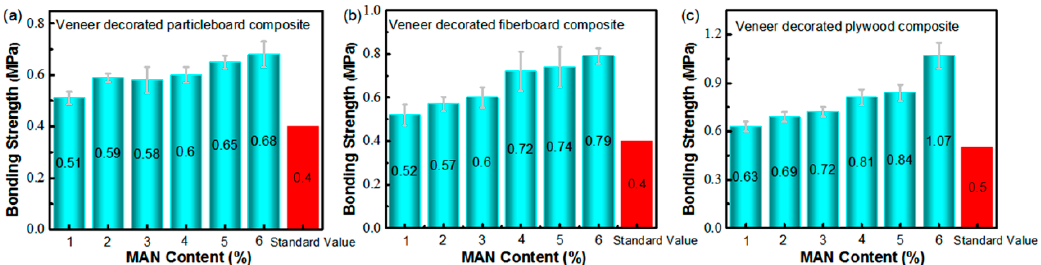
Figure 3. Optimization of the maleic anhydride (MAN) content of the three wood-based panel composites—( a ) the veneer-decorated particleboard composite; ( b ) the veneer-decorated fiberboard composite; and ( c ) the veneer-decorated plywood composite.